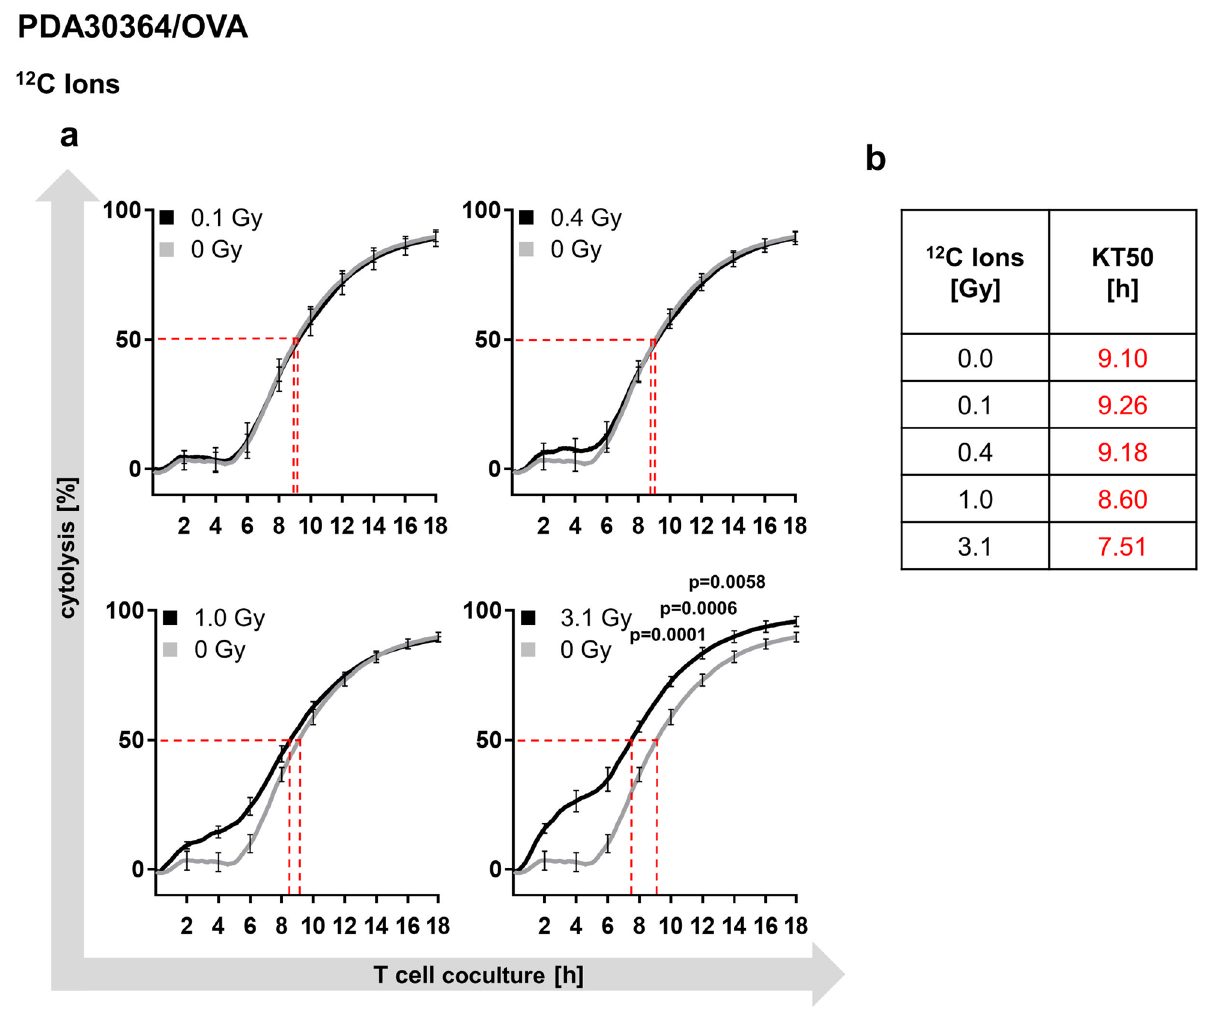
Figure 5. Carbon ion irradiation enhances susceptibility of PDA30364/OVA cells to CTL lysis. Cytolysis of PDA30364/OVA cells following irradiation with increasing carbon ion doses monitored for 18 h and quantified by impedance-based cytotoxicity assay (xCELLigence); dashed lines show “Kill-Time-50” (KT50) values; effector to target cell ratio was 2.5:1 ( a ). Time span elapsed until 50% of target cells had underwent CTL mediated lysis was expressed as KT50 ( b ). Representative results of one out of three independent experiments performed are